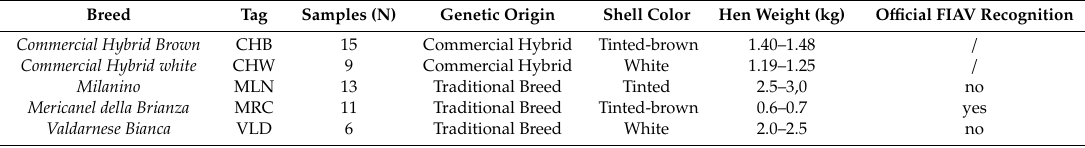
Table 1. Birds’ breeds, number of samples ( N ), genetic origin (commercial hybrid; traditional breed), egg shell color, hen weight (kg), official registration by Federazione Italiana Associazioni Avicole